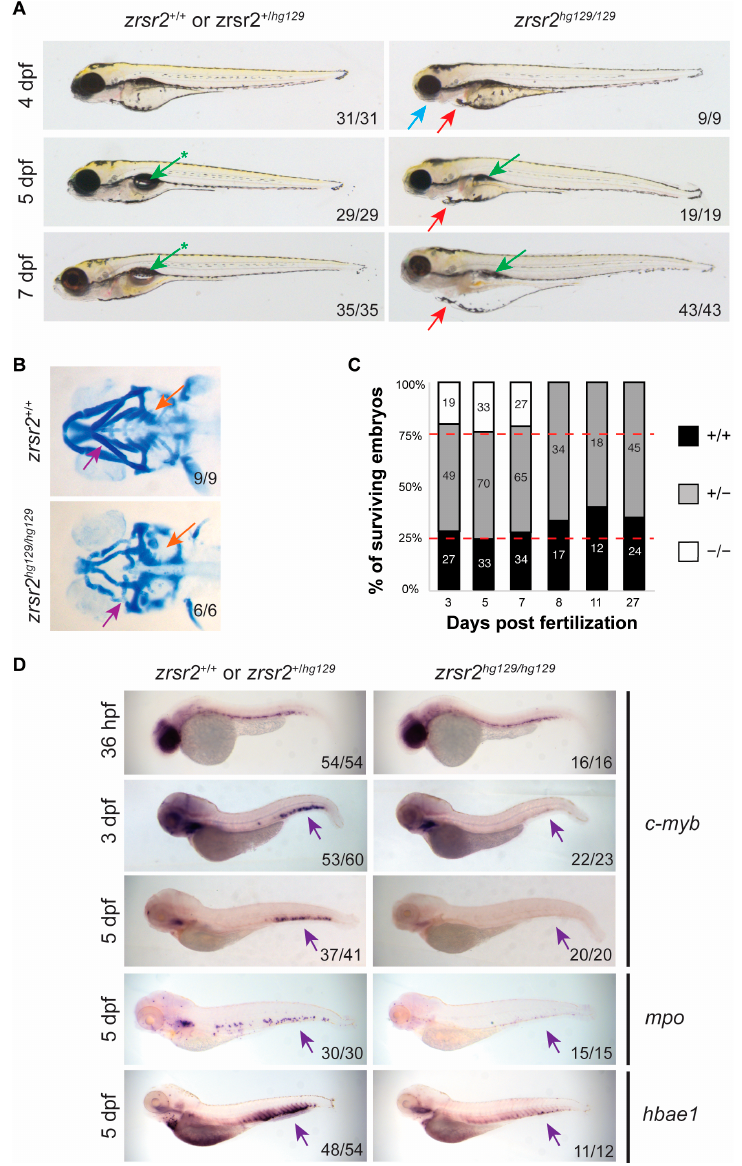
Figure 3. zrsr2 -knockout embryos display morphological and hematopoietic defects. ( A ) Morpholog- ical phenotypes of zrsr2 hg129/hg129 embryos at 4, 5, and 7 dpf are shown in the right panel compared to their WT siblings in the left panel. Blue arrow marks defective jaw, red arrows mark cardiac edema, green arrows mark uninflated swim bladder, and green arrows with asterisks mark the normal inflated swim bladder in WT embryos. All images depict lateral views of the embryos. ( B ) Ventral view of embryos stained with Alcian blue depicting the cartilage of developing jaw of WT embryos (top panel) and zrsr2 hg129/hg129 embryos (bottom panel) at 4 dpf with purple arrows marking the mandibular cartilage and orange arrows marking the pharyngeal arches. ( C ) Survival of embryos collected from adult zrsr2 hg129/+ in-cross. The bar graph displays the genotype ratios as a percentage of total sampled embryos, and red lines indicate the expected Mendelian offspring ratios (1:2:1; zrsr2 +/+ : zrsr2 hg129/+ : zrsr2 hg129/hg129 ). Numbers in the bars represent the number of embryos of each genotype. Clutches were sampled for genotype makeup at multiple time points as marked on the X-axis. zrsr2 hg129/hg129 embryos died by 8 dpf, while zrsr2 hg129/+ and zrsr2 +/+ embryos survived to adulthood. ( D ) WISH for definitive hematopoietic markers c- myb (36 hpf, 3 dpf, and 5 dpf), mpo (5 dpf) and hbae1 (5 dpf), showing expression in zrsr2 hg129/hg129 embryos (right panel) compared to their siblings (left panel). Lateral views of embryos are shown in all images, with purple arrows marking the CHT region, showing reduced expression in zrsr2 hg129/hg129